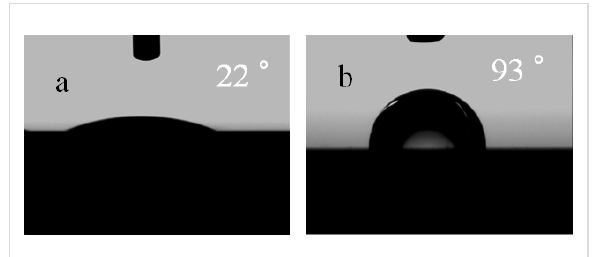
Figure 9: Static-contact-angle images of water droplets on a silicon wafer cast with (a) original imogolite and (b) DDPO 4 -imogolite. Reprinted with permission from W. Ma et al., Chem. Lett. 2011, 40, 159–161 [33]. © 2011, The Chemical Society of